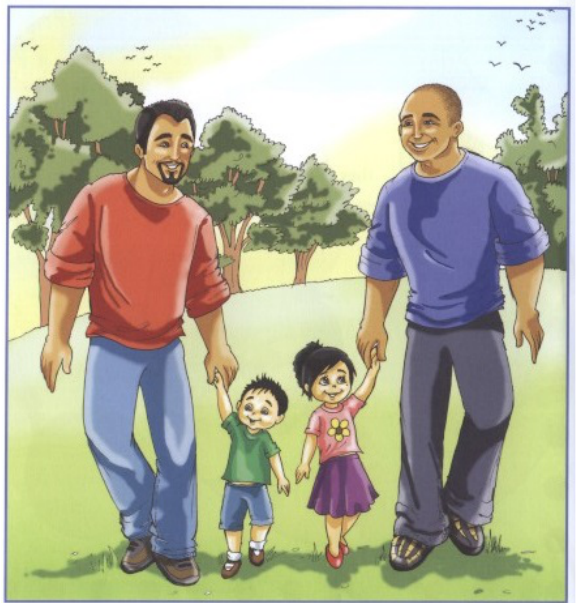
Figure 8. The opening Image of My Two Uncles & Me.